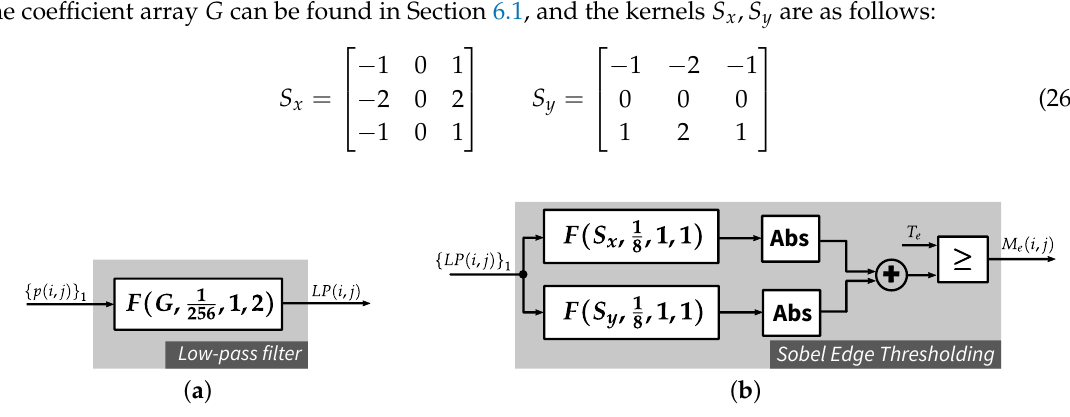
Figure 13. Edge detection module: ( a ) low-pass filter; and ( b ) Sobel edge thresholding module.